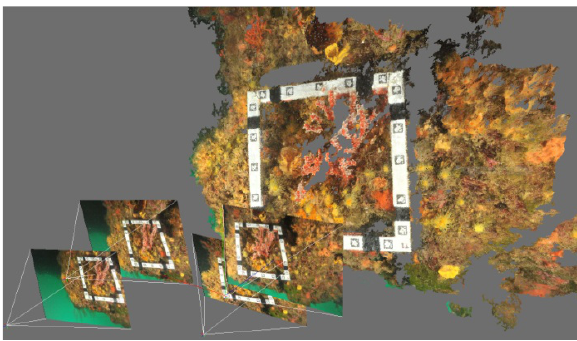
Figure 10. Dense cloud of point measured automatically to check the manual measure.